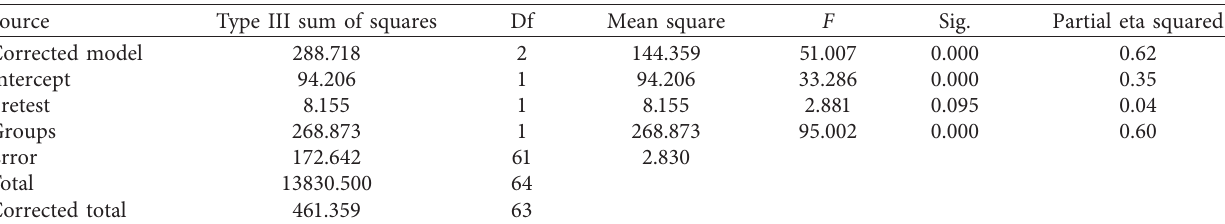
Table 3: Results of one-way ANCOVA for comparing the posttest scores of the EG1 and CG learners. Source Type III sum of squares